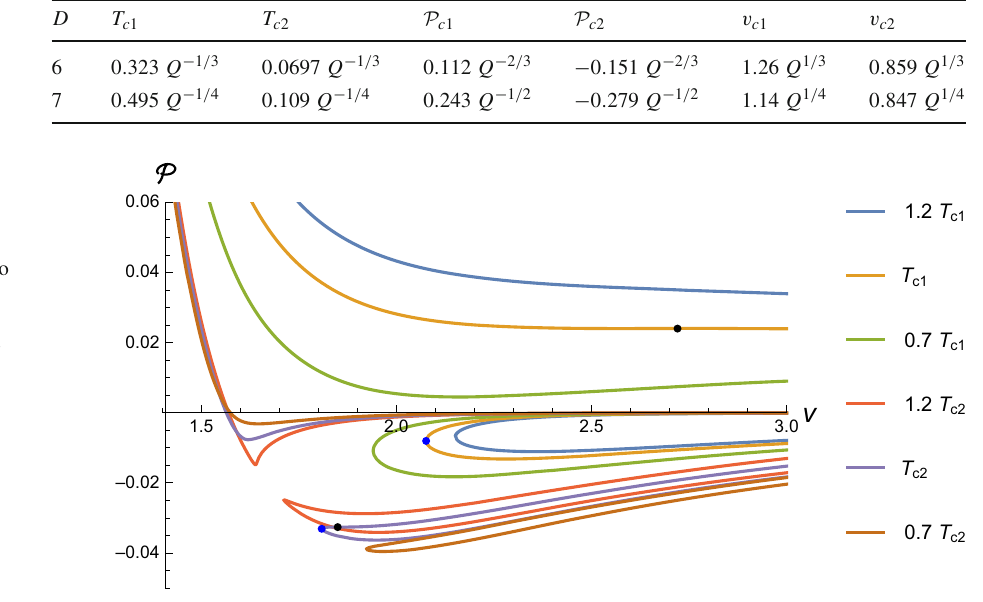
with N = 2 in six and seven